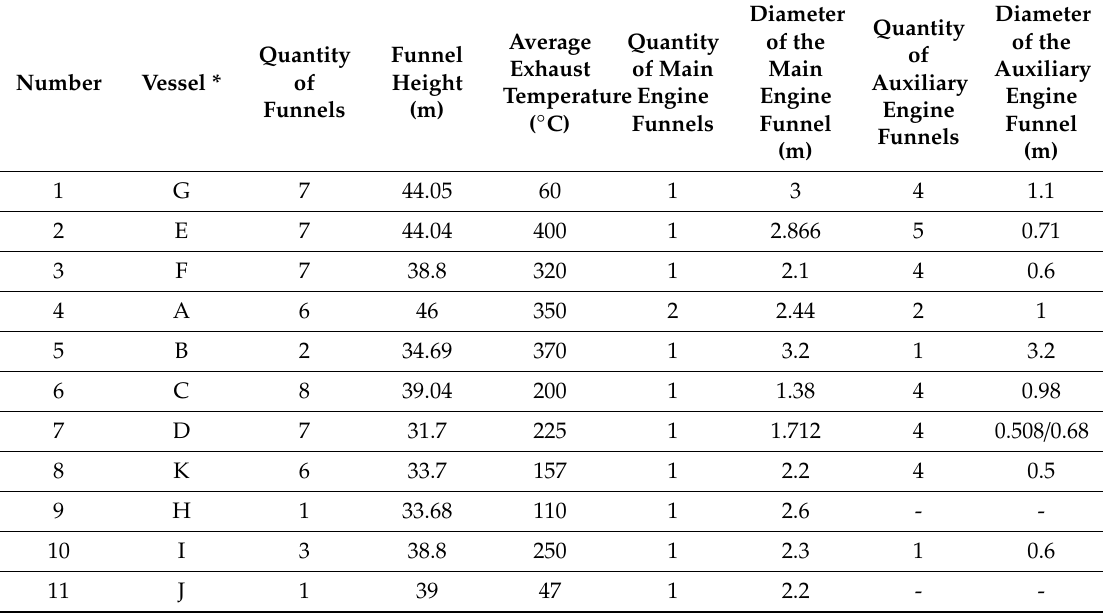
Table 2. Vessel funnel parameters.